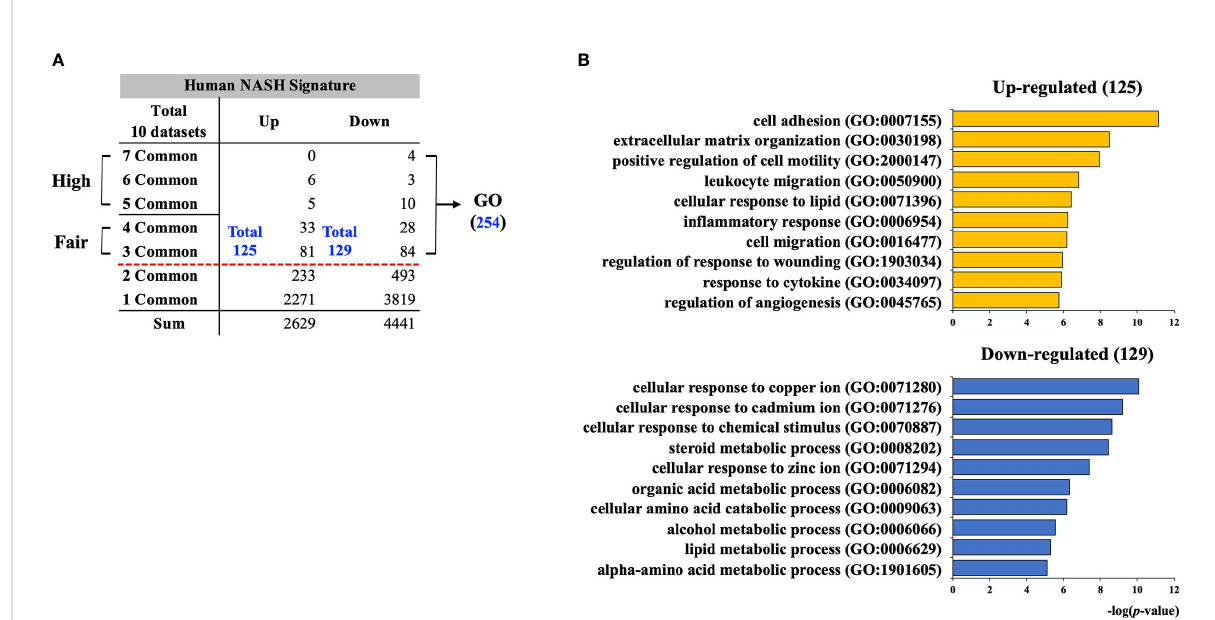
FIGURE 2 Establishment of human NASH signature and functional enrichment analysis. (A) Individually selected DEGs from 10 human NASH datasets were merged based on the gene symbols and the frequency score of each DEG was calculated. Total 254 genes (125 up-regulated and 129 down- regulated) were consistently dysregulated in at least three datasets. DEGs with frequency scores of 3 and 4 were classi fi ed as “ Fair con fi dent ” , and frequency scores of 5 to 7 were classi fi ed as “ High con fi dent ” genes. (B) GO BP enrichment analysis result for 254 human NASH signatures. NASH, nonalcoholic steatohepatitis; GO BP, gene ontology biological